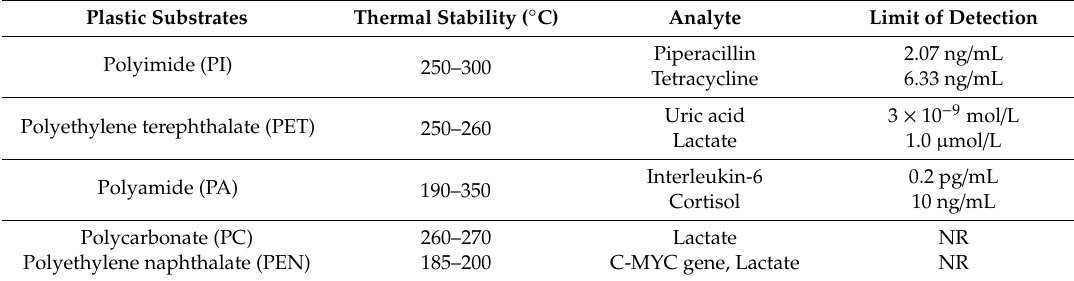
Table 1. Flexible substrates incorporated in lab ‐ on ‐ chip devices [26,27] .